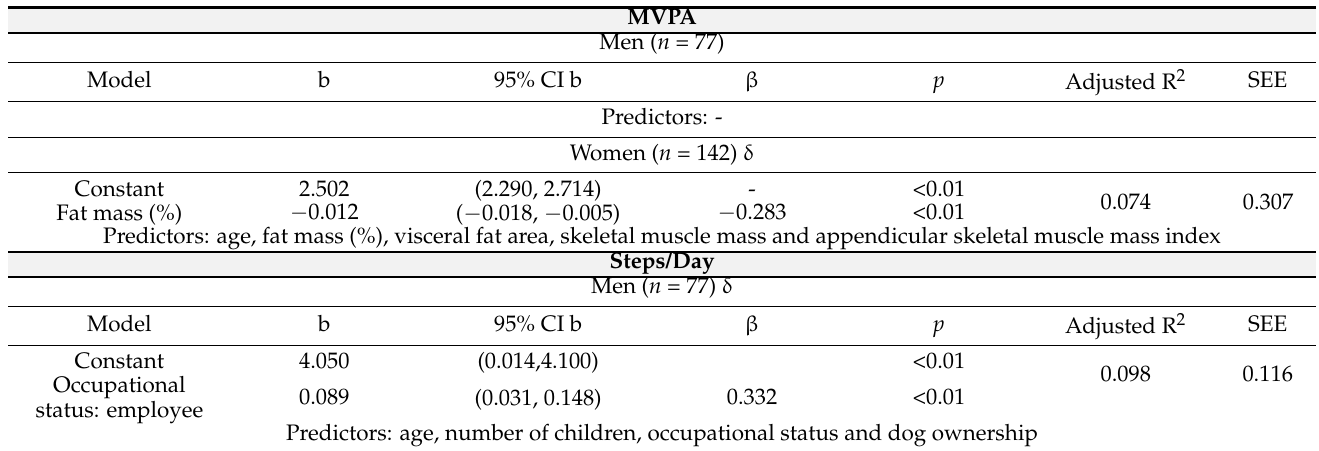
Table 5. Multiple linear regressions developed in both genders for the